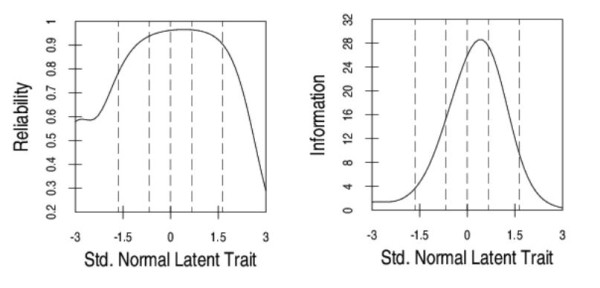
Reliability curve and item information curve for HAM-Nat-uni.